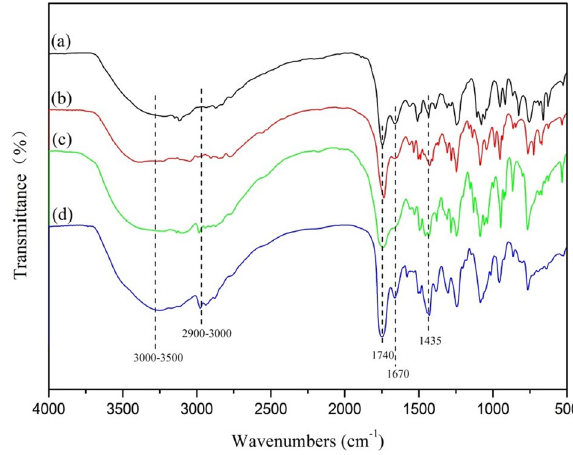
Fig. 1 FTIR spectra of IM-TT ( a ), 2MI-TT ( b ), 2EI-TT ( c ) and EMI-TT ( d